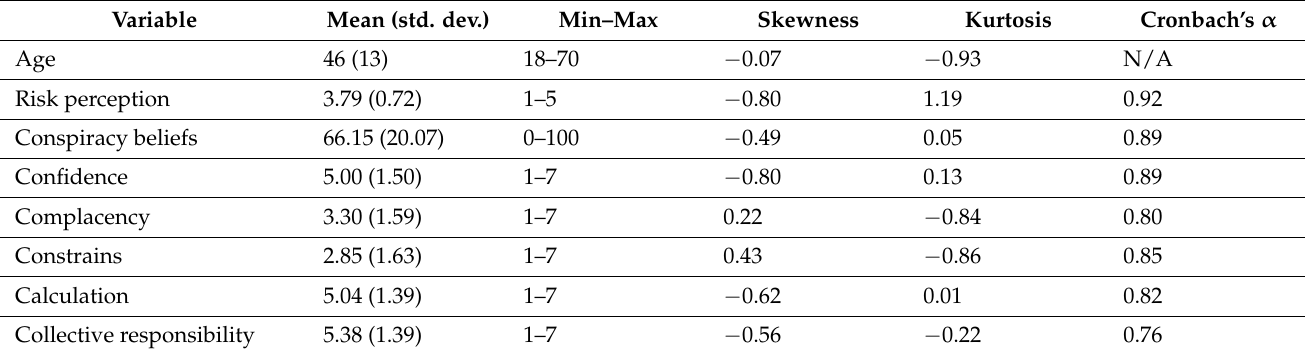
Table 2. Descriptive statistics and reliability